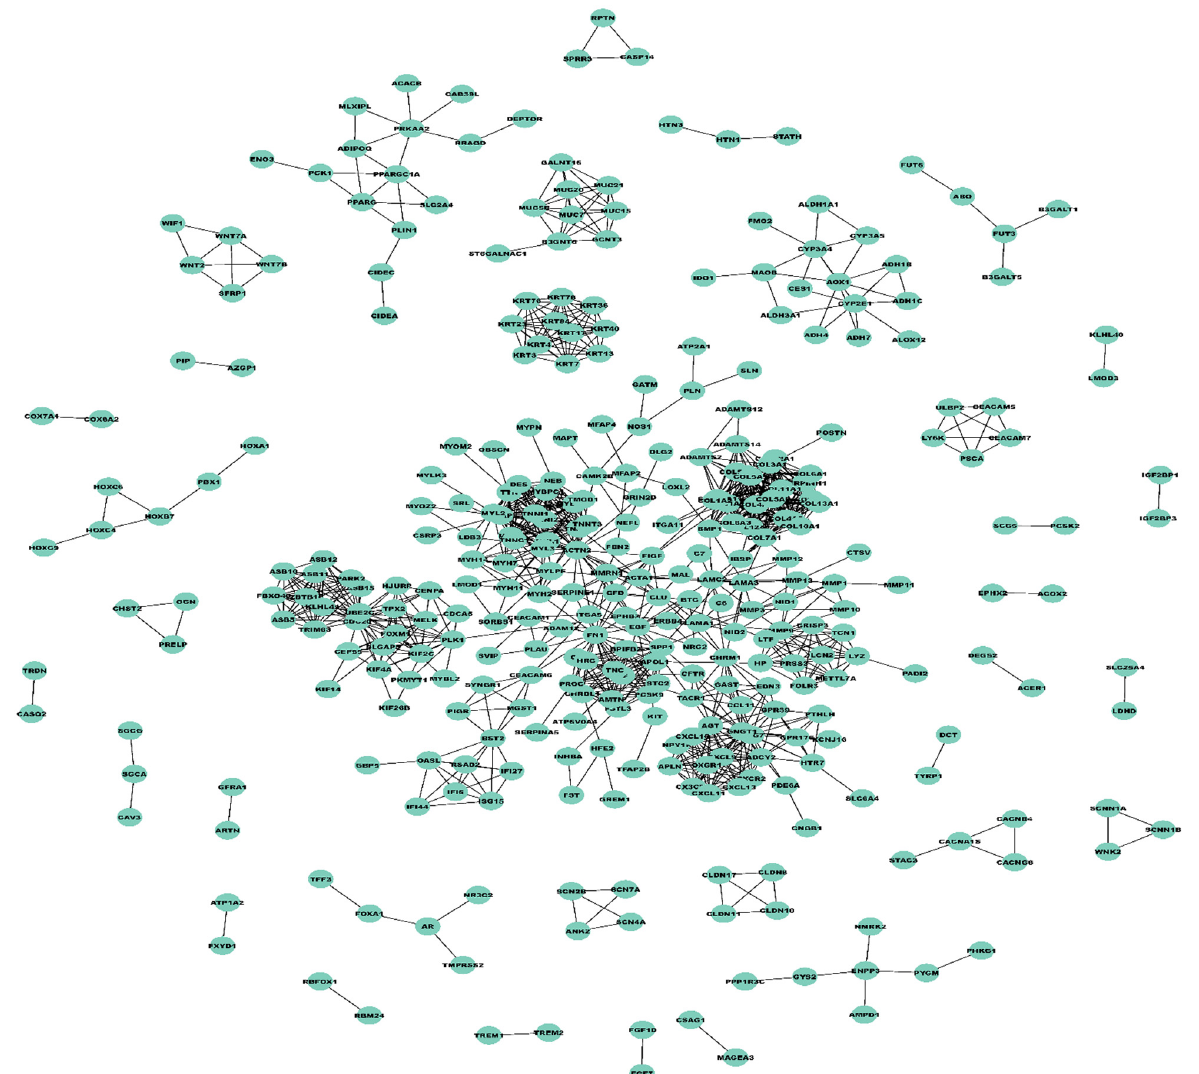
Figure 3. Weighted PPI network comprising 346 nodes and 1207 edges, visualized using Cytoscape.